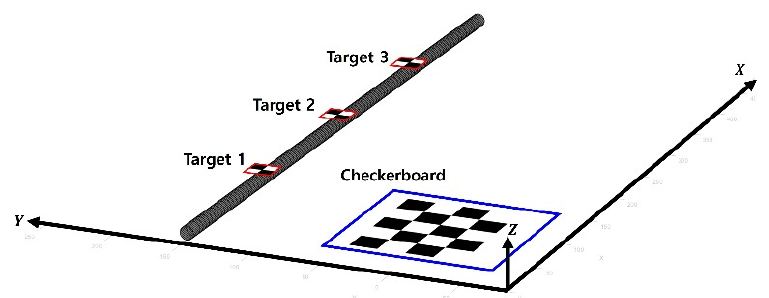
Figure 6. Configuration of the simulation-based validation test.